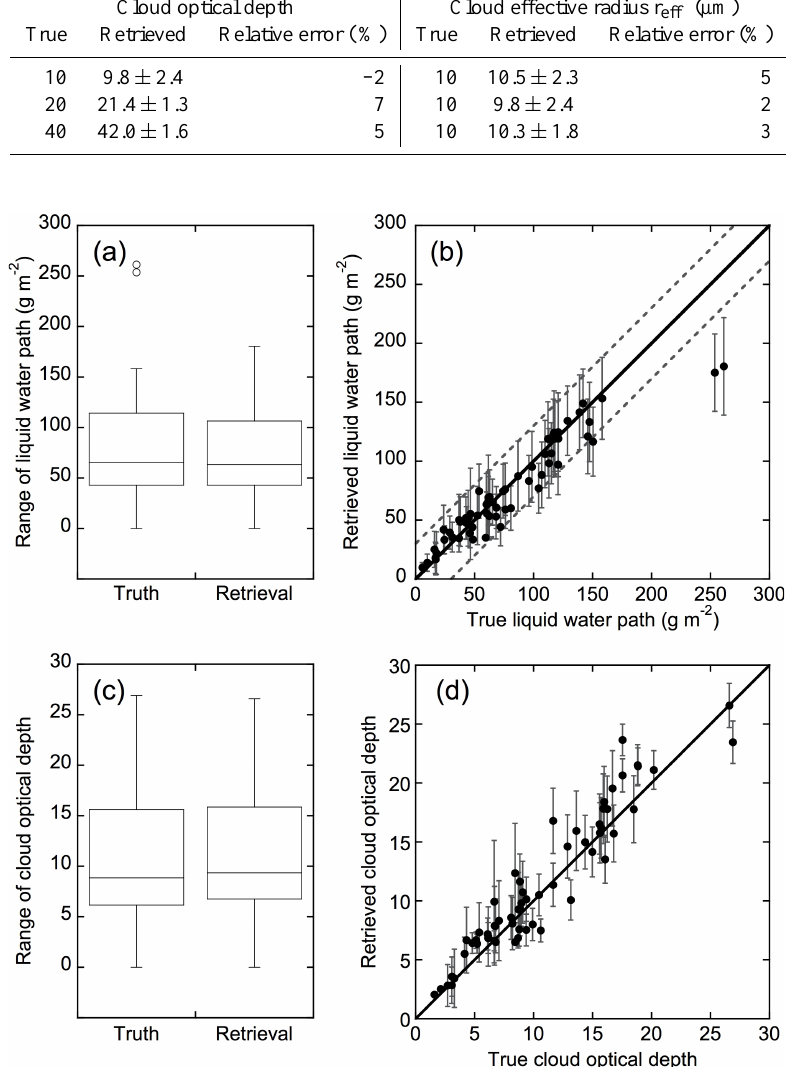
Fig. 5. Intercomparison between the true and the retrieved liquid water paths using box plot (a) and scatter plot (b) , for the simulation in Fig. 4. The bottom and top of each box represent the 25% and 75% quartiles, and the line inside the box represents the median (Tukey, 1977, p. 41–43). The whiskers mark the “accepted range”, which is defined as 1.5 times the interquartile distance. The open circles outside the accepted range are considered outliers. The error bars in (b) represent one standard deviation of retrievals from the 40 realizations in the retrieval process, while the co-plotted dashed lines represent a typical uncertainty of 30gm − 2 in liquid water path retrieved from microwave radiometer measurements. (c) and (d) are the same as (a) and (b) , respectively, but for cloud optical depth.